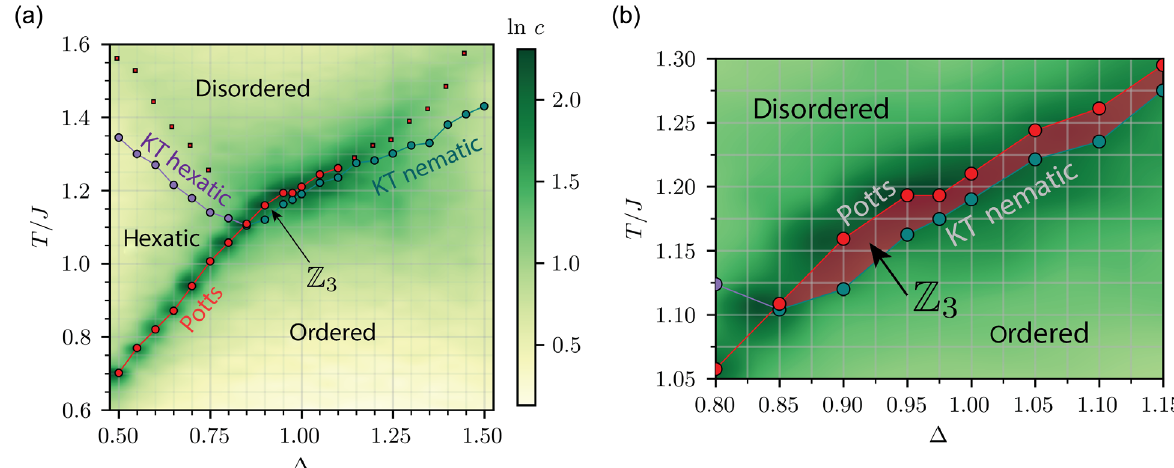
FIG. 4. (a) Numerical phase diagram of the coupled hexatic-nematic XY model in Eq. (3.1) as a function of the temperature T and ratio of exchange couplings Δ ¼ J 2 =J obtained from classical Monte Carlo simulations. The hexatic-nematic coupling strength is set to λ ¼ 2 . 1 and J ¼ 1 J J c at system size L ¼ 40 (see logarithmic color bar). 2 þ 6 Þ . Background color density denotes specific heat per site 2 ð We distinguish four different phases: (i) a disordered phase with purely short-range correlations, (ii) a hexatic phase with algebraic correlations of h cos ð θ i − θ j Þi ∼ j i − j j − η 6 , (iii) a Z 3 Potts phase with long-range correlations h cos ð σ i − σ j Þi → constant > 0 as j i − j j → θ − 3 ϕ = 3 but short-range correlations of hexatic and nematic angles, and (iv) an ordered phase with algebraic ∞ with σ i ¼ ð i i Þ correlations of both hexatic and nematic degrees of freedom and long-range Potts correlations. Here, h O i denotes the thermal average. The KT transition temperatures (blue and purple dots) are obtained from the total stiffness jump criterion. The size of the jump is used to 2 T = π (unbinding of q 1 vortices, blue), and a hexatic-KT distinguish between a nematic-KT transition, where ρ ð T ϕ ¼ KT Þ ¼ KT 18 T = π (unbinding of q 1 vortices, purple). Note that we present the extrapolated KT critical transition, where ρ ð T θ ¼ KT Þ ¼ KT temperatures to infinite system size (Fig. 6). The Potts transition temperature T 3 (red dots) is determined from the maximum of the specific heat c at L ¼ 40 , except at Δ ¼ 0 . 95 , 1.0, where T 3 is obtained by fitting c to the Potts scaling form c ¼ t − α with t ¼ j T − T 3 j =T 3 and α ¼ 1 = 3 (Figs. 5 and 6). Consistent Potts transition temperatures are obtained from a universal scaling analysis of the magnetization, susceptibility, and specific heat, as shown in Fig. 7. The red squares for Δ ≥ 1 . 15 track a broad maximum of c associated with the KT nematic transition at T 2 , demonstrating that the nature of the upper phase transition changes from Potts to KT at Δ ¼ 1 . 15 . On the left side of the phase diagram, the red squares correspond to the second, lower maxima of the specific heat corresponding the proliferation of hexatic vortices above the hexatic-KT transition. (b) Enlargement of the region with relative Z 3 Potts order. The Potts phase exists for 0 . 9 ≤ Δ ≤ 1 . 15 and extends over a region Δ T=J ≈ 0 . 005